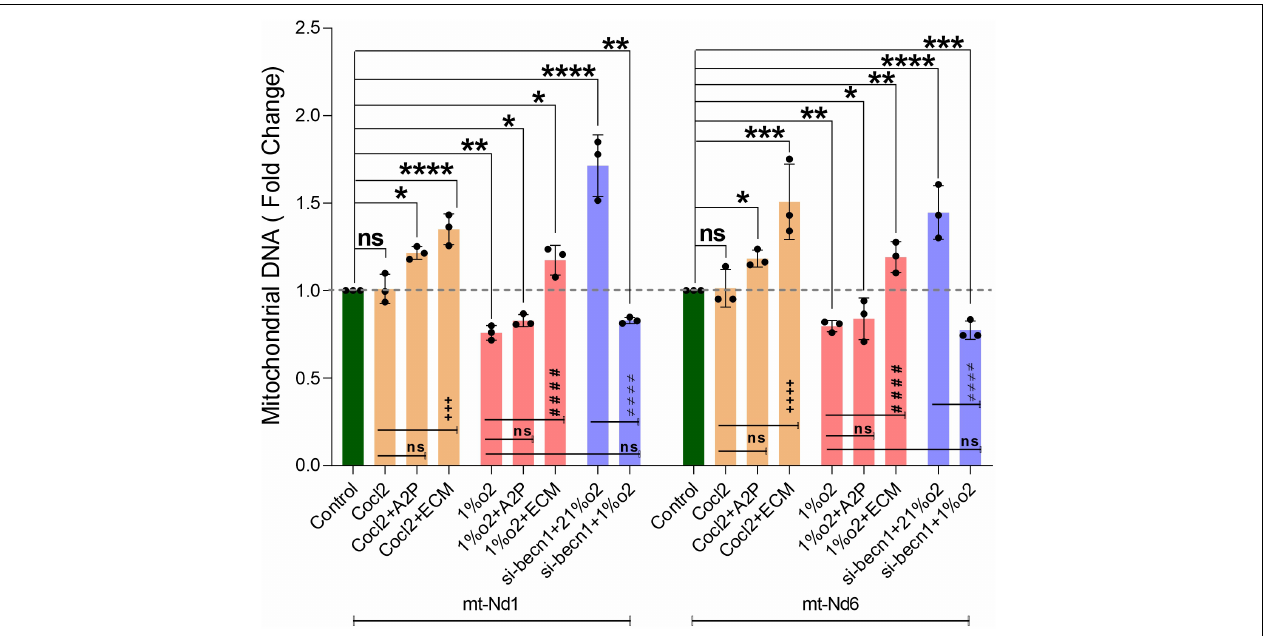
FIGURE 10 | Hypoxia decrease the H9c2 cells Mitochondrial DNA levels. The graph indicates the Mitochondrial DNA encoded genes ( Mt-Nd1 and Mt-Nd6 ) levels in H9c2 cells treated with ECM, A2P, siRNA-Beclin1 and grown under CoCl2, Hypoxia (1%O2), and Normoxia conditions (21%O2). Mitochondrial DNA ( Mt-Nd1 and Mt-Nd6 ) levels were increased significantly in Cocl2 + A2P, Cocl2 + ECM, and in Hypoxia + ECM groups, and the Mt-DNA levels were decreased in Hypoxia (1%O2), Hypoxia (1%O2) + A2P groups. Beclin-1 inhibition cells Mt-DNA ( Mt-Nd1 and Mt-Nd6 ) levels increased in normoxia (21%O2) and were decreased in hypoxia (1%O2) exposed cells. Compared to Hypoxia cells, 1%O2 + ECM cells express increased Mt-DNA levels. Mitochondrial DNA levels was normalized to nuclear DNA levels (Tubulin A1) and relative Mt-DNA levels are expressed as fold change to controls. Data represents n = 3 independent samples/group; Bars are mean ± S.D. Symbols * , + , # and (cid:54)= denotes significant, “ns” represents not significant by two-way ANOVA- multiple comparisons test. P-values are ns p > 0.05, * p < 0.05, ** p < 0.01, *** p < 0.001 and **** p < 0.0001 compared to Control; + p < 0.05, ++ p < 0.01, +++ p < 0.001 and ++++ p < 0.0001 compared to Cocl2; # p < 0.05, ## p < 0.01, ### p < 0.001 and #### p < 0.0001 compared to Hypoxia; (cid:54)= p < 0.05, (cid:54)= (cid:54)= p < 0.01, (cid:54)= (cid:54)= (cid:54)= p < 0.001 and (cid:54)= (cid:54)= (cid:54)= (cid:54)= p < 0.0001 compared to si-becn1 (21%O2) Vs, si-becn1